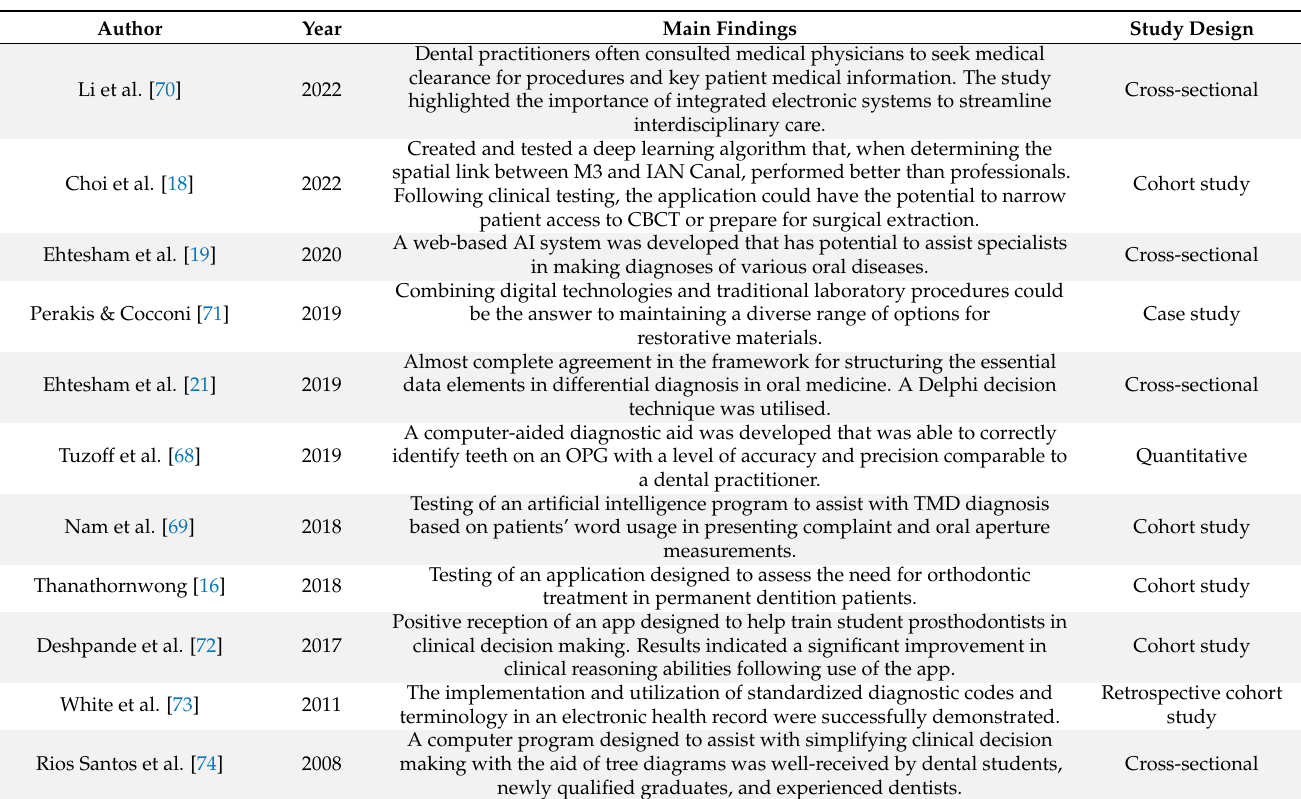
Table 5. Extracted articles that investigated artificial intelligence and informatics in clinical decision making under